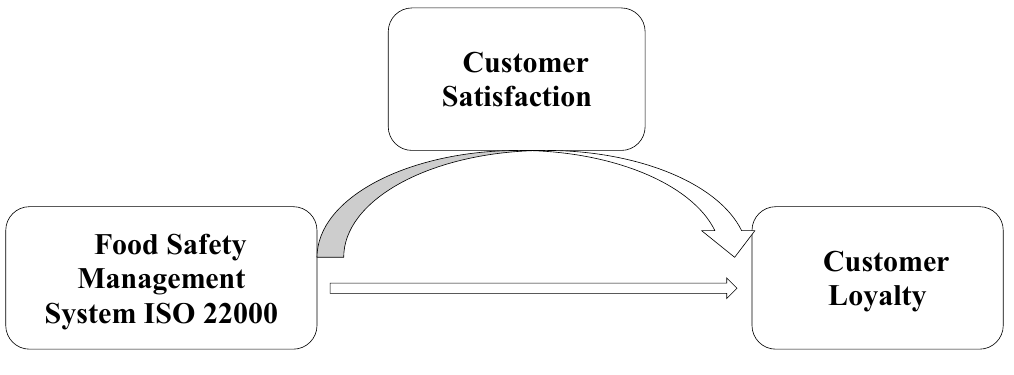
Fig. 1. The conceptual model of the research,